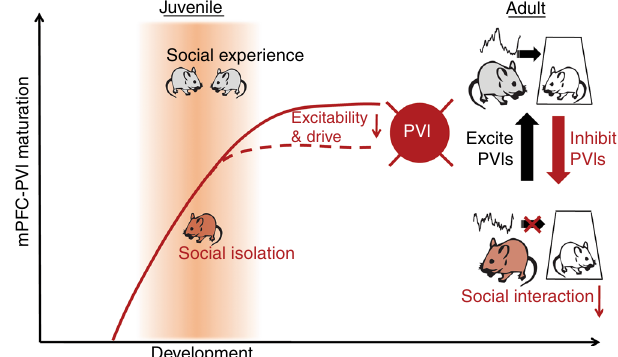
Fig. 7 Summary Scheme: PFC-PVIs show decreased excitability and drive following juvenile social isolation, a manipulation that leads to decreased social interaction. In group housed adults, short dmPFC-PVI activation induced by optogenetics mirrors naturally observed pre-active dmPFC-PVI activity, and leads to social approach. This relationship is not observed in juvenile socially isolated mice. Decreased social interaction can be induced in group housed animals by inhibiting PFC-PVI in adult mice; social interaction of isolated mice can be mitigated by increasing PFC-PVI